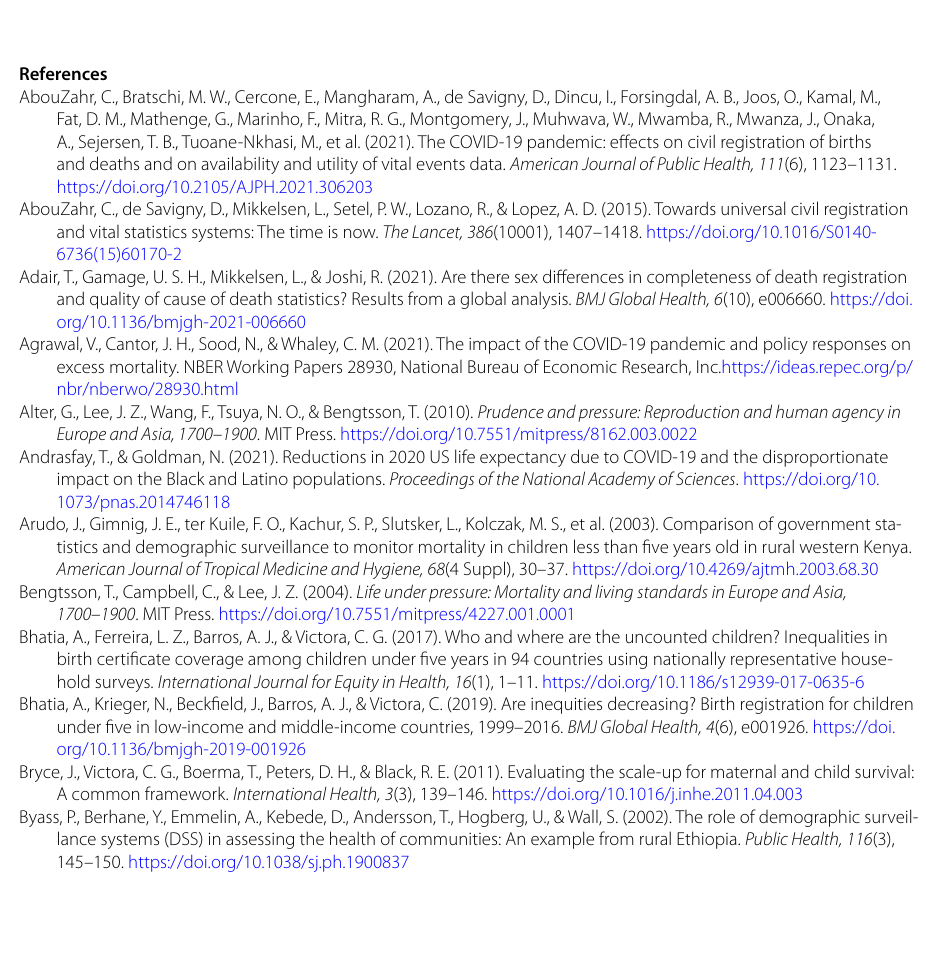
Abbreviations CRVS: Civil registration and vital statistics system; DHS: Demographic and Health Survey; IUSSP: International Union for the Scientific Study of Population; NPR: National Population Register; SARS-CoV-2: Severe acute respiratory syndrome coronavirus 2; SDG: Sustainable Development